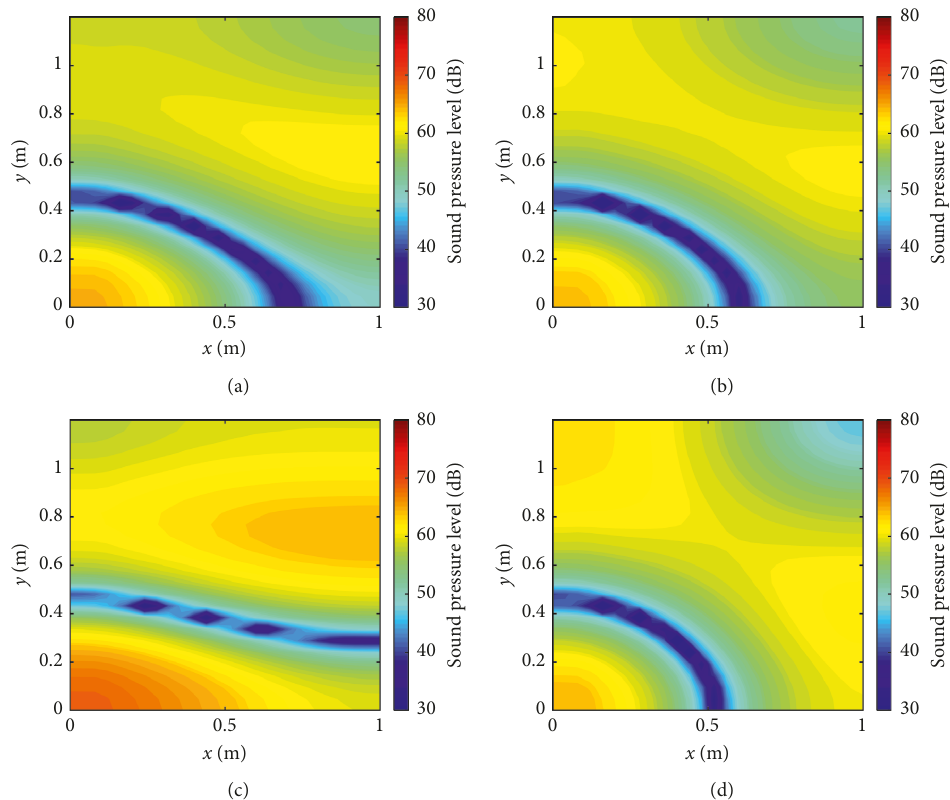
Figure 5: Distributions of sound pressure level at the top surface of the cavity at 270Hz. (a) Reference method. (b) Hybrid SFEM. (c) NS- FEM. (d)